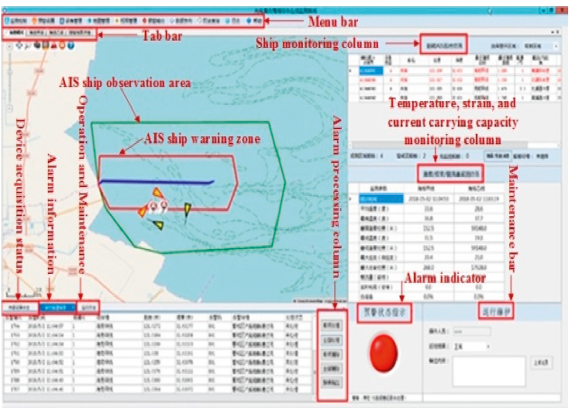
Figure 10: Main interface of ship monitoring system software in offshore wind farms.